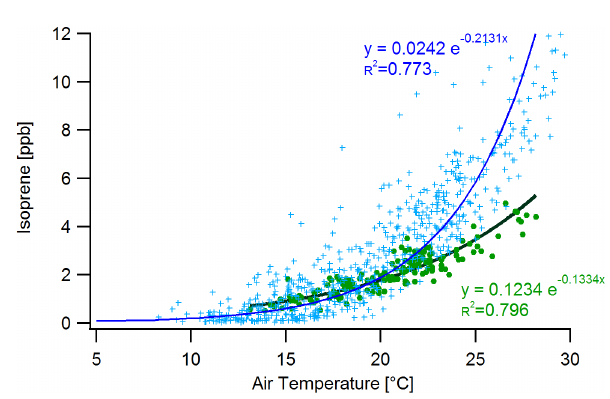
Figure 4. Relationship between daytime isoprene mixing ratios (ppbv) and air temperature ( ◦ C). Data points and fit lines in green and blue correspond to measurements at 10 and 2m height respec- tively.